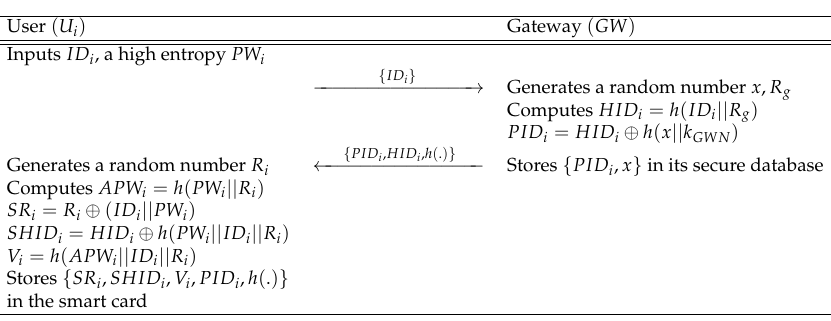
Figure 6. User registration phase of